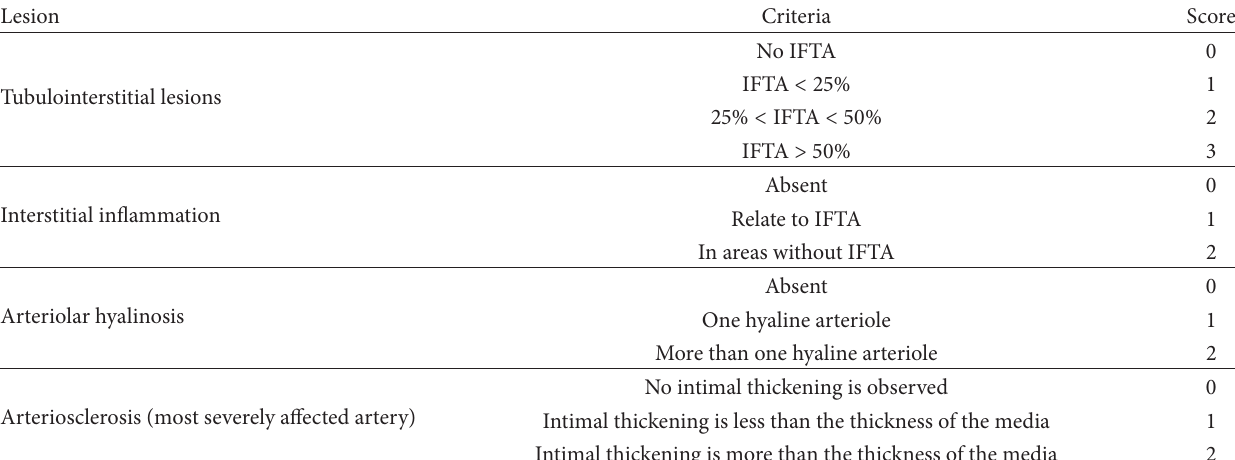
Table 2: Separate scoring system of interstitial and vascular lesions of